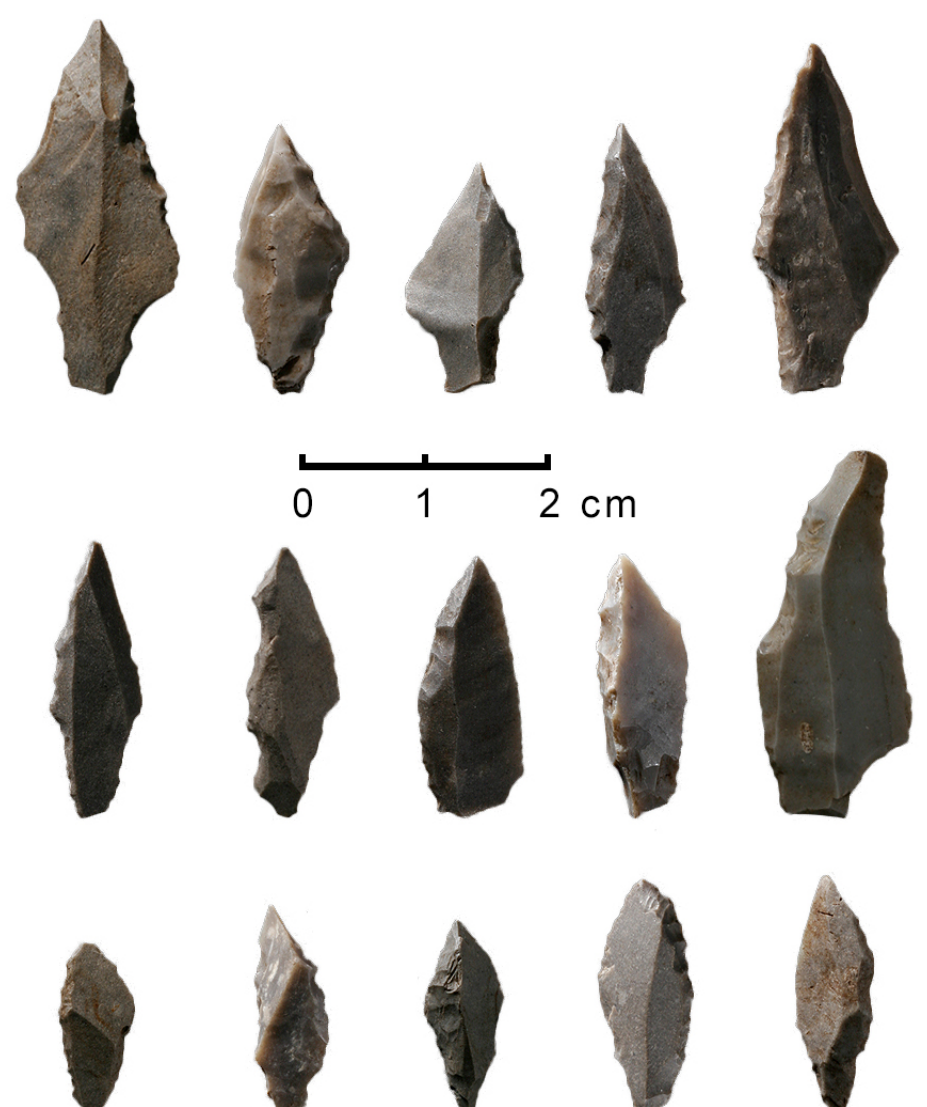
Figure 6. A selection of traditional and single-edged tanged points from Ormen Lange Locality 48, Aukra, Central Norway, c. 9100-8500 cal. BCE. Compare the first arrowhead in the second row with the Brodgar point in Figures 3 and 4. (Photo modified from NTNU Vitenskapsmuseet – Leif Inge